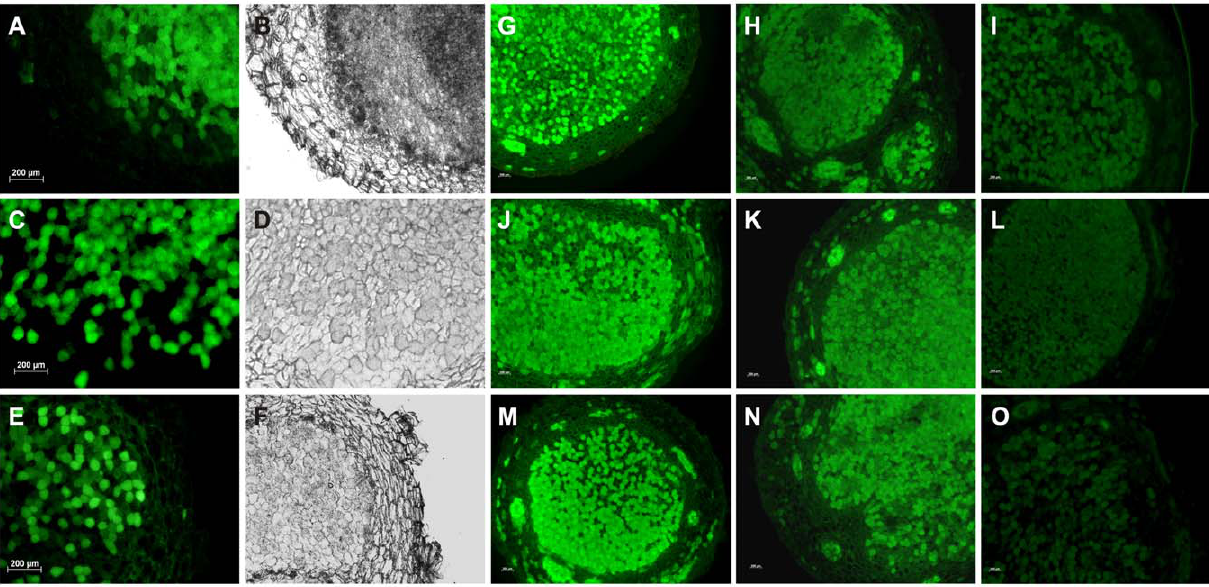
Figure 2. RSH and/or RSNO detection in A.hypogaea JL 24 nodules. A. hypogaea nodule sections were incubated with 10 m M Alexa fluor 488 Hg-linked phenylmercury at 25 u C for 2 hour in darkness. Photographs are representative of results obtained from the analysis of nodules in five independent experiments. Images of nodules show RSH, RSNO, disulphide linkage and background dependent Alexa fluor 488 fluorescence (green colour) in (A) 20 day, (C) 40 day and (E) 80 day old nodules. (B), (D) and (F) show the corresponding bright field images. Further experiments were performed to confirm the presence of RSNO in the nodule sections. Control set cross sections of 20 (G), 40 (J) and 80 (M) day old nodules were treated with buffer only; corresponding sections of different day old nodules (H), (K), (N) were treated with 50 mM L-NEM and were incubated at 25 u C for 2 h in darkness; sections (I), (L), (O) were incubated with 20 mM ascorbate for 1 hour at room temperature followed by similar NEM treatment. All the sections were stained with 10 m M alexafluor 488 at 25 u C for 2 h in darkness. (G), (J), (M) depicts the presence of RSH, RSNO, disulphide linkage and background fluorescence; the fluorescence of (H), (K), (N) were due to RSNO, disulphide linkage and background fluorescence whereas (I), (L), (O) represents the fluorescence for disulphide linkage and back ground. The fluorescence intensity difference between (H, I), (K, L), and (N, O) confirms for the presence of RSNO (for calculation see further Figure 4) in the corresponding day of A. hypogaea nodule sections. Scale bar=200 m m.